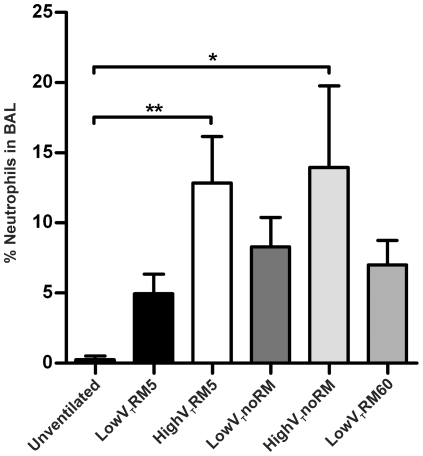
Neutrophils in BAL fluid.BAL fluid was subjected to cytospin preparation, followed by Diff-Quick staining. From each preparation 400 cells were counted and percentage of neutrophils was calculated. (Unventilated: n = 5, lowVTRM5 n = 5, highVTRM5 n = 5, lowVTnoRM n = 4, highVTnoRM n = 4, lowVTRM60 n = 5). § *** p<0.001 versus all other groups.